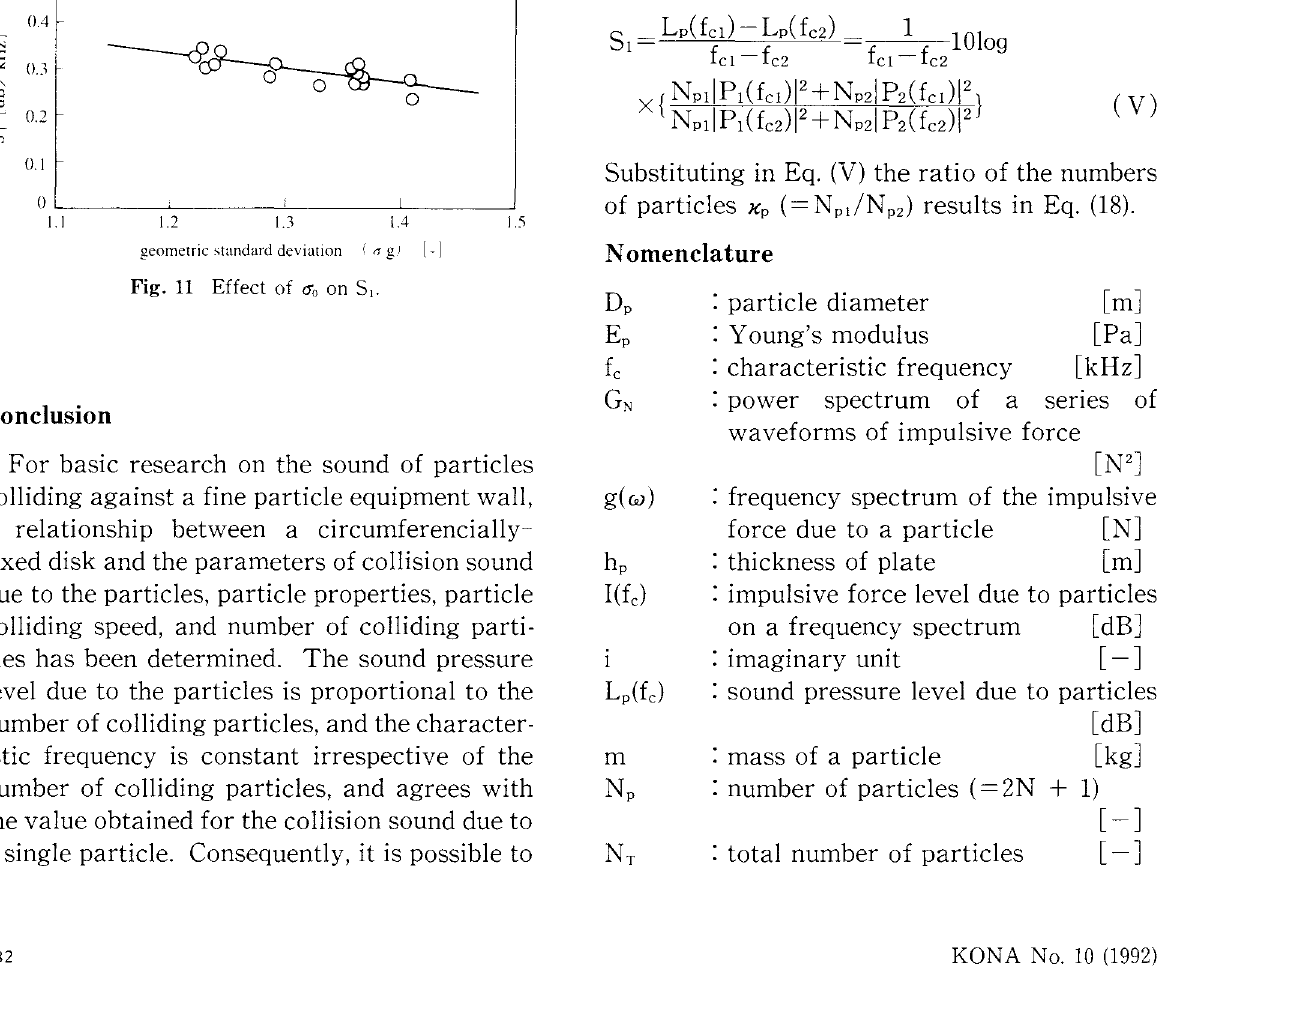
Fig. 10 Relationship between Q and Lp(fciJ-